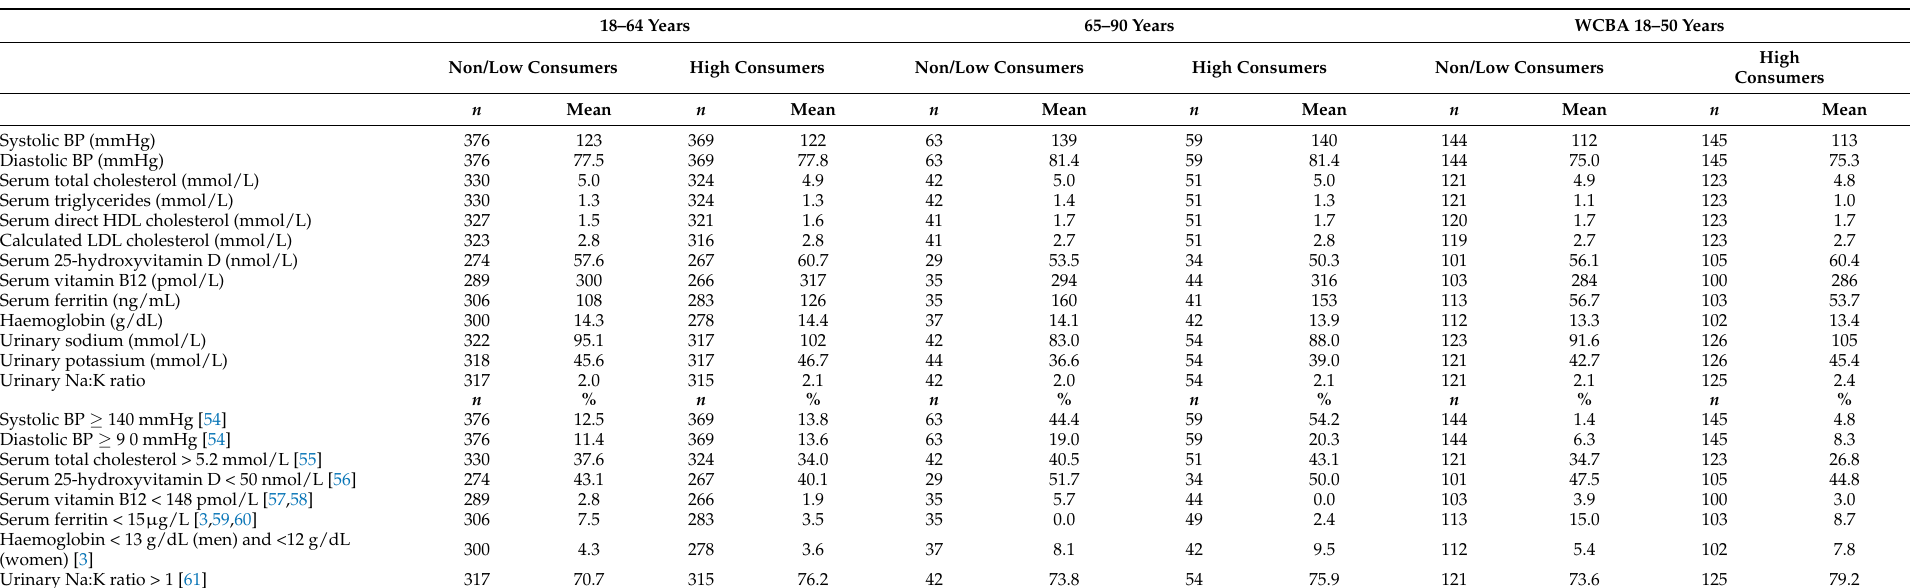
Table 4. Mean blood pressure, lipoprotein, cholesterol and biochemical markers of nutritional status values and the proportion (%) of the population with values outside generally accepted cut-offs indicating high or low/deficient status in non/low and high consumers of ‘fresh beef and lamb’ in adults aged 18–90 years, by age